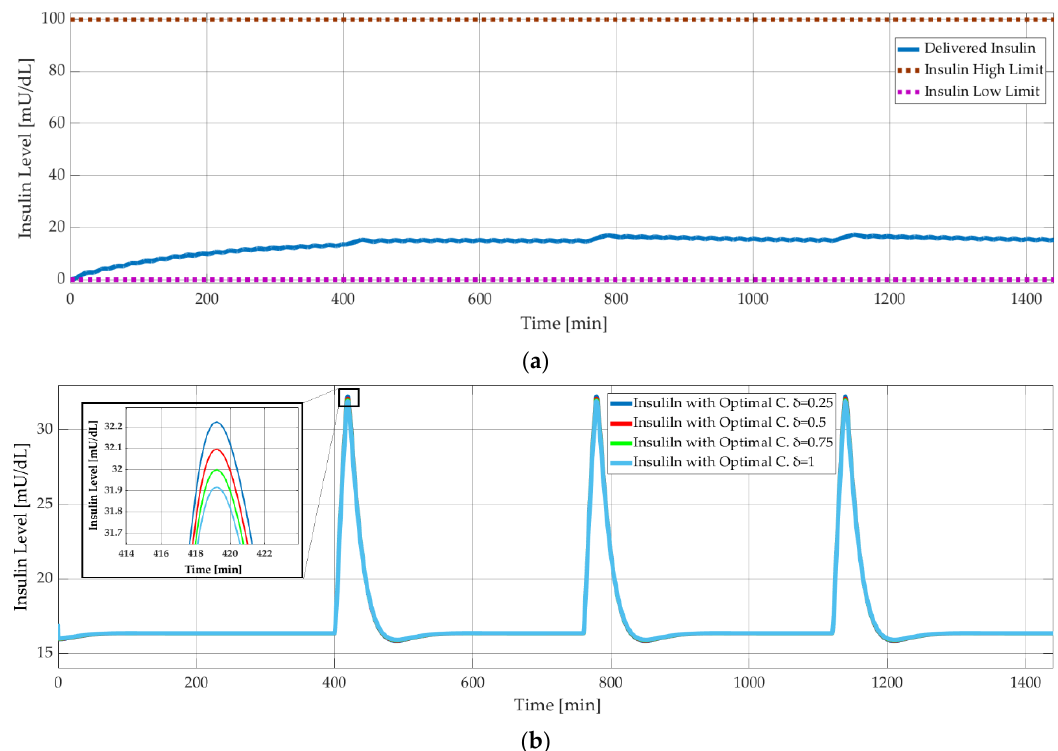
Figure 10. Model-based simulation results: ( a ) insulin level versus time with PID controlled Sorensen model; ( b ) insulin level versus time with optimal controlled Bergman model.